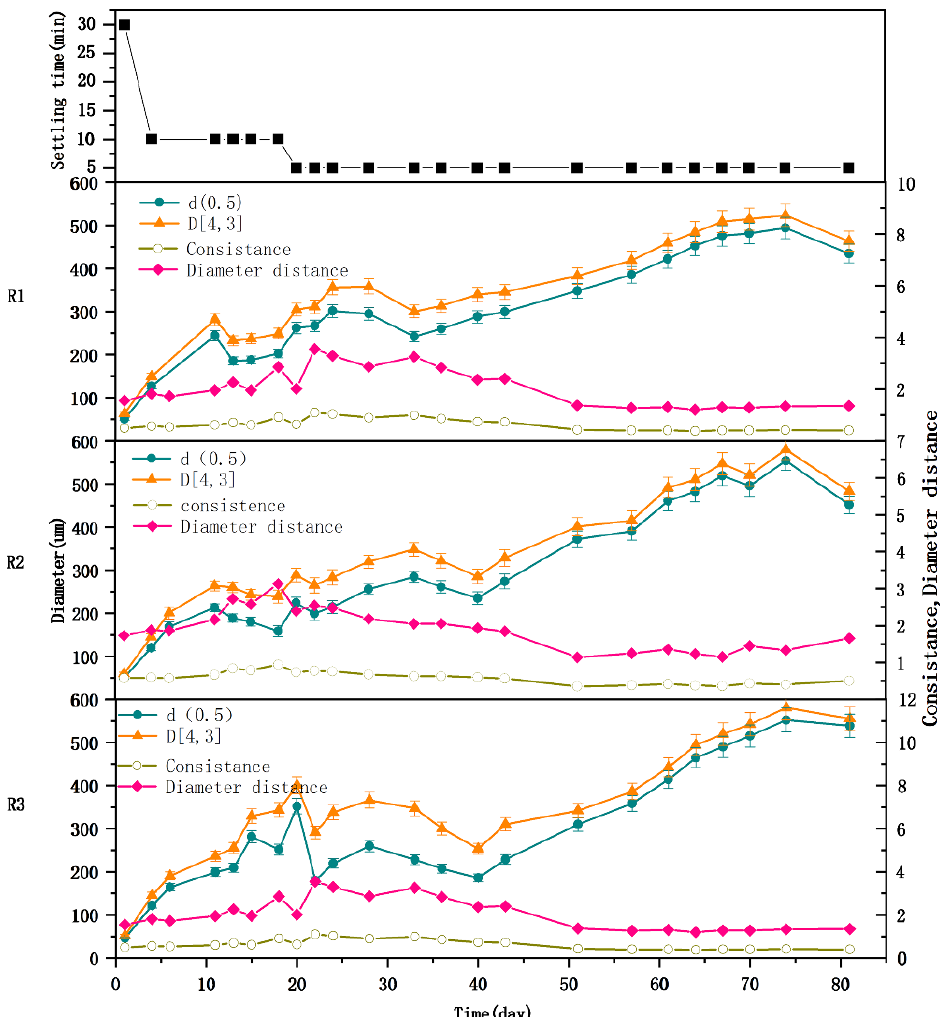
Figure 3. The change in diameter of aerobic granules in the formation process in R1, R2, and R3. In this study, the biomass sizes in R1, R2, and R3 started from 62.84 ± 3.12 µ m, 60.12 ± 3.14 µ m, and 51.64 ± 2.58 µ m, respectively. They were increased with the operation time. On day 51, the size of the biomass in R1, R2, and R3 increased to 382.56 ± 19.12 µ m, 400.96 ± 20.95 µ m, and 341.61 ± 17.08 µ m, respectively. At the steady state, the average sizes of aerobic granules in R1, R2, and R3 were 469.42 ± 46.43 µ m, 493.48 ± 61.08 µ m, and 482.59 ± 85.05 µ m, respectively. The d(0.5) of R1, R2, and R3 have similar trends to that of D[4,3]. The diameter distance indicates the measurement width distribution. The smaller the value, the narrower the distribution. The average diameter distance of R1 was 1.75 ± 0.34. For R2, the average diameter distance was 1.93 ± 0.56. The average diameter distance of R3 was 2.08 ± 0.75. Thus, granules in R1 had the smallest difference from each other when the reactor reached a steady state.